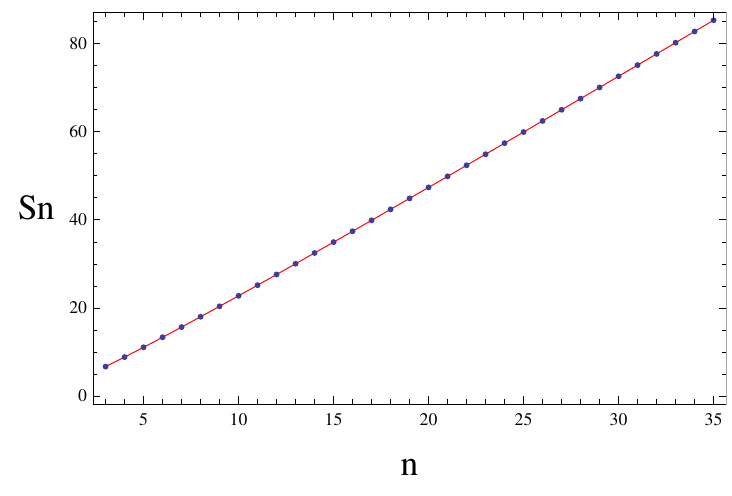
Figure 15 . The entanglement entropy of gauge (cid:12)eld with algebra B